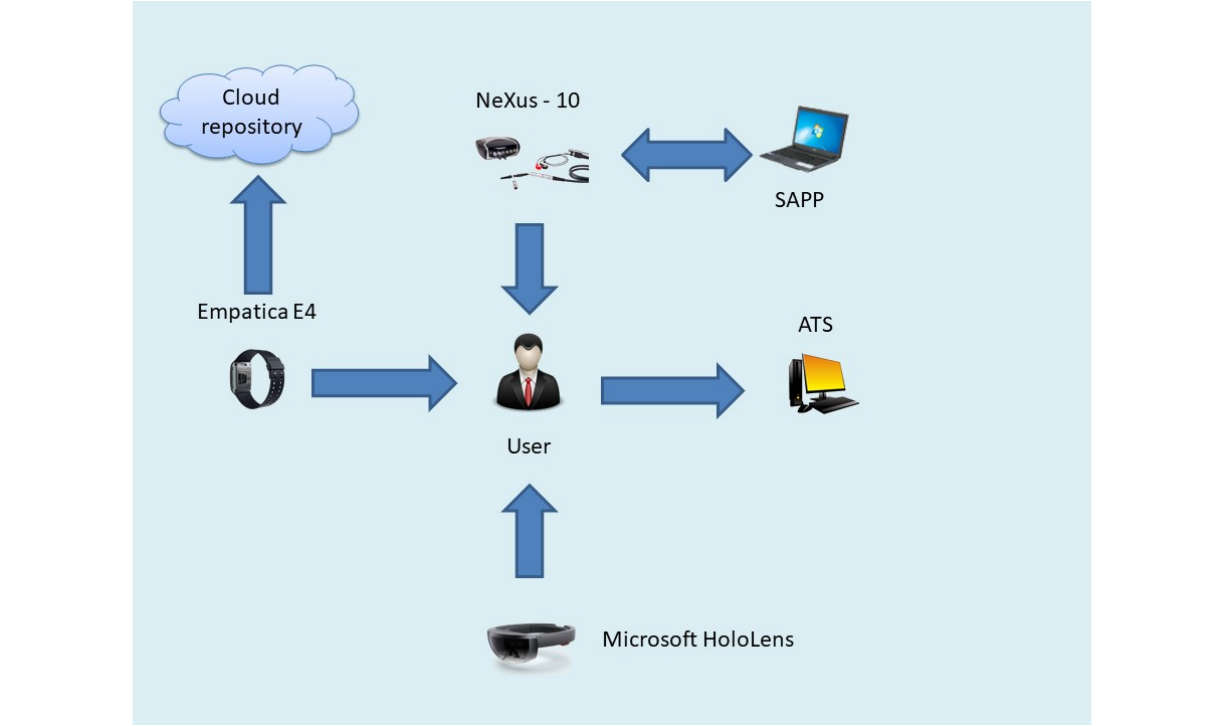
Figure 2. Multimodal biosignal sensors and mixed reality equipment setup. ATS: activity and time stamp synchronization; SAPP: signal acquisition and